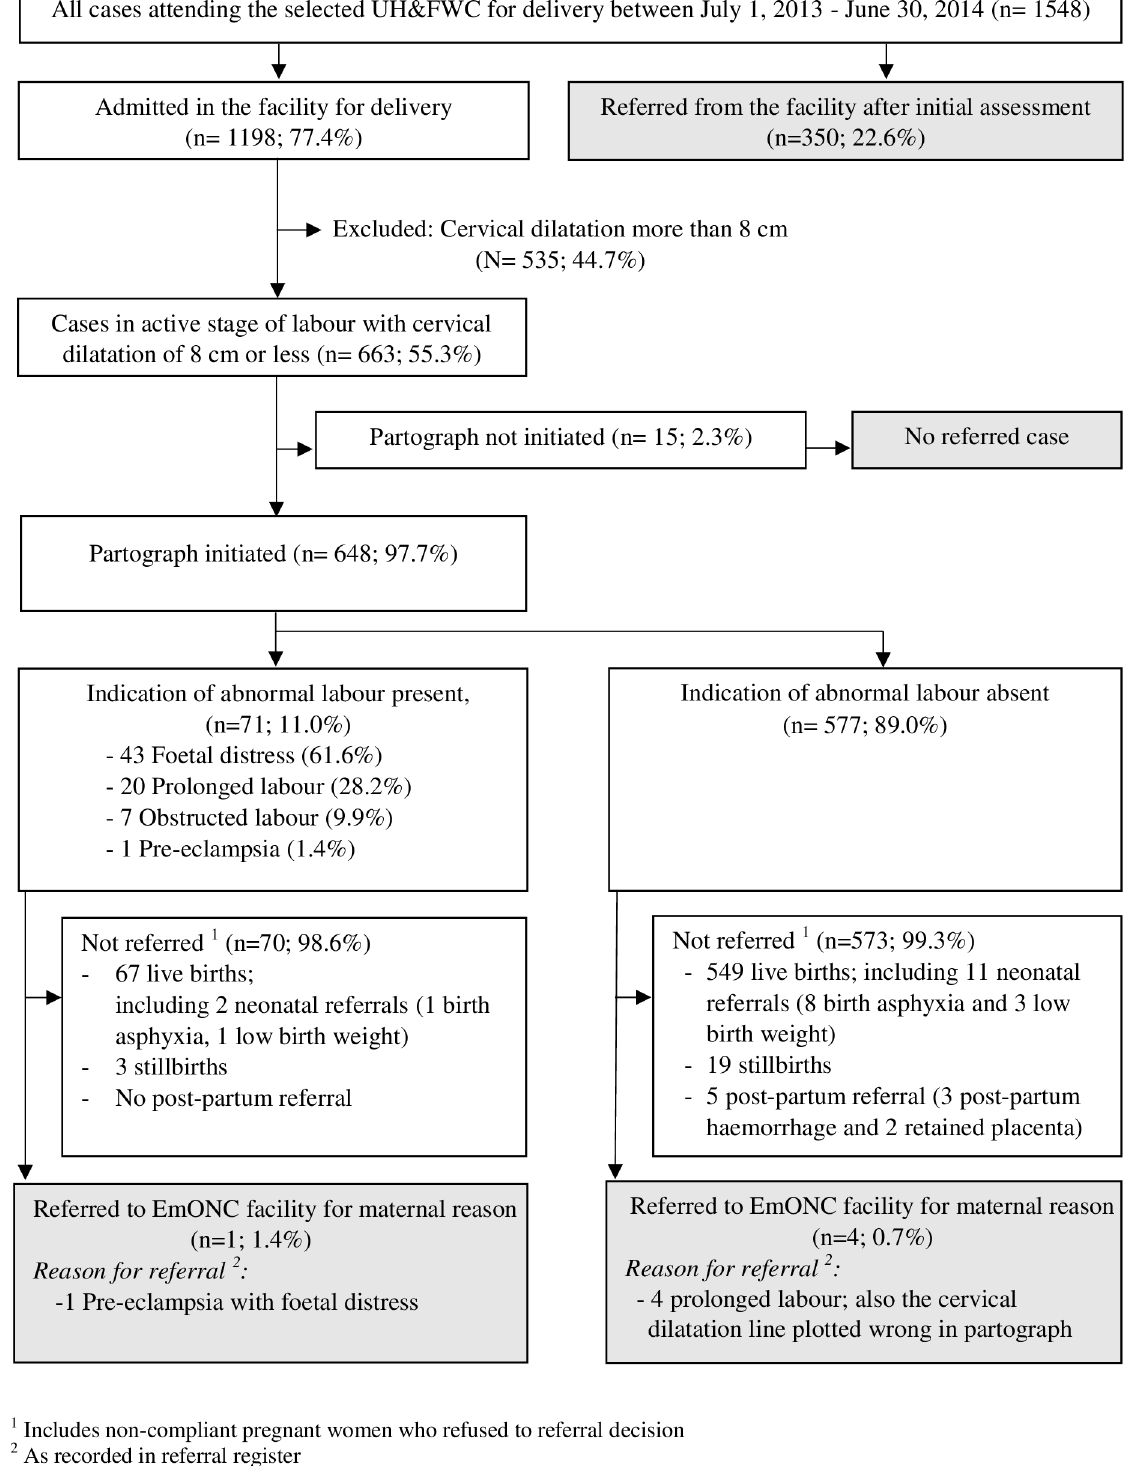
Fig 1. Flow diagram showing selection of cases with partograph, indication of abnormal labour in partograph and referred case with and without partograph indication of abnormality.